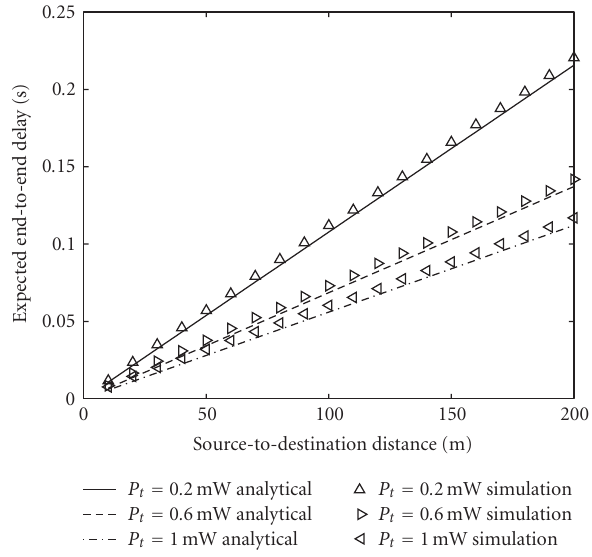
Figure 5: Expected delay versus source-to-destination distance l ( λ = 0 . 1 / m 2 ).